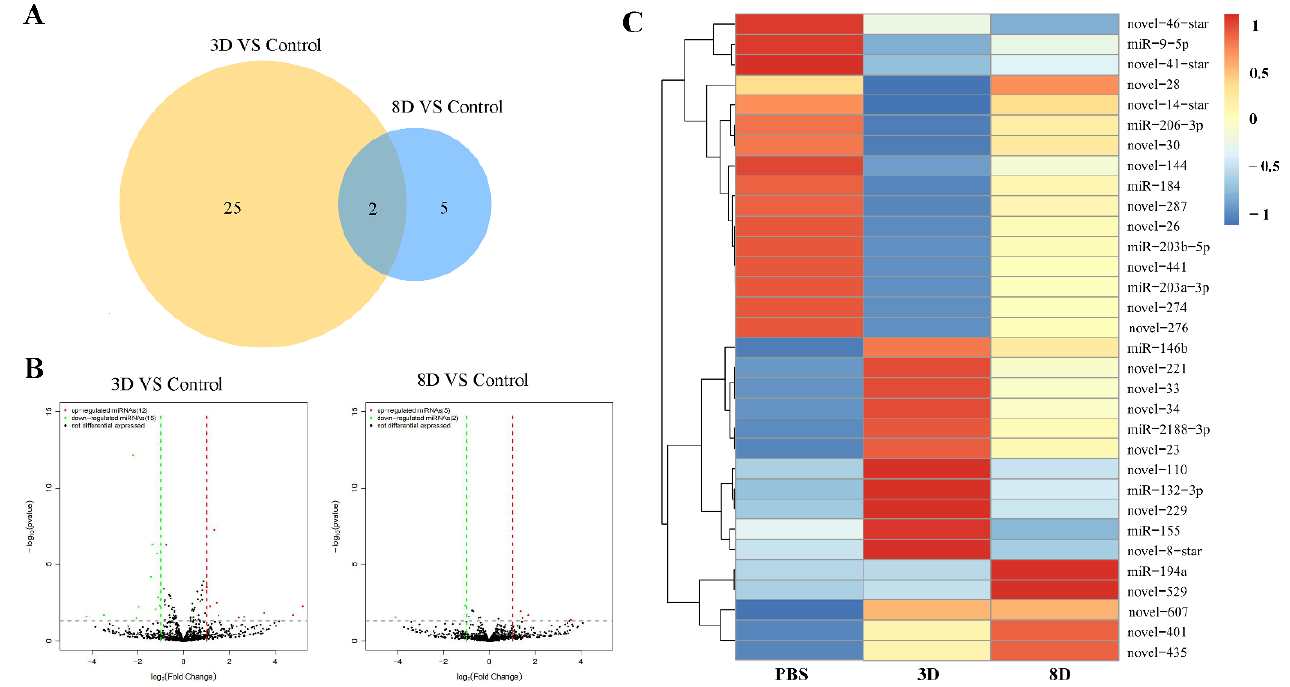
Figure 1. Analysis of differentially expressed miRNAs (DEmiRs) in C. altivelis following NVV challenge. ( A ) Venn diagram shows DEmiRs numbers in the two infected groups compared to the control group. The DEmiRs number between the 3D and control groups was orange, while it was light blue between the 8D and control groups. ( B ) The volcano map shows the overall distribution of DEmiRs. Red color represents significantly differentially up-regulated, while the green color represents significantly differentially down-regulated. Black dots represent non-significantly differential expression. ( C ) The expression patterns for the 32 DEmiRs. The expression levels of these 32 miRNAs are shown in different colors. The red color indicates the highly expressed DEmiRs, and the blue color for the lowly expressed DEmiRs.